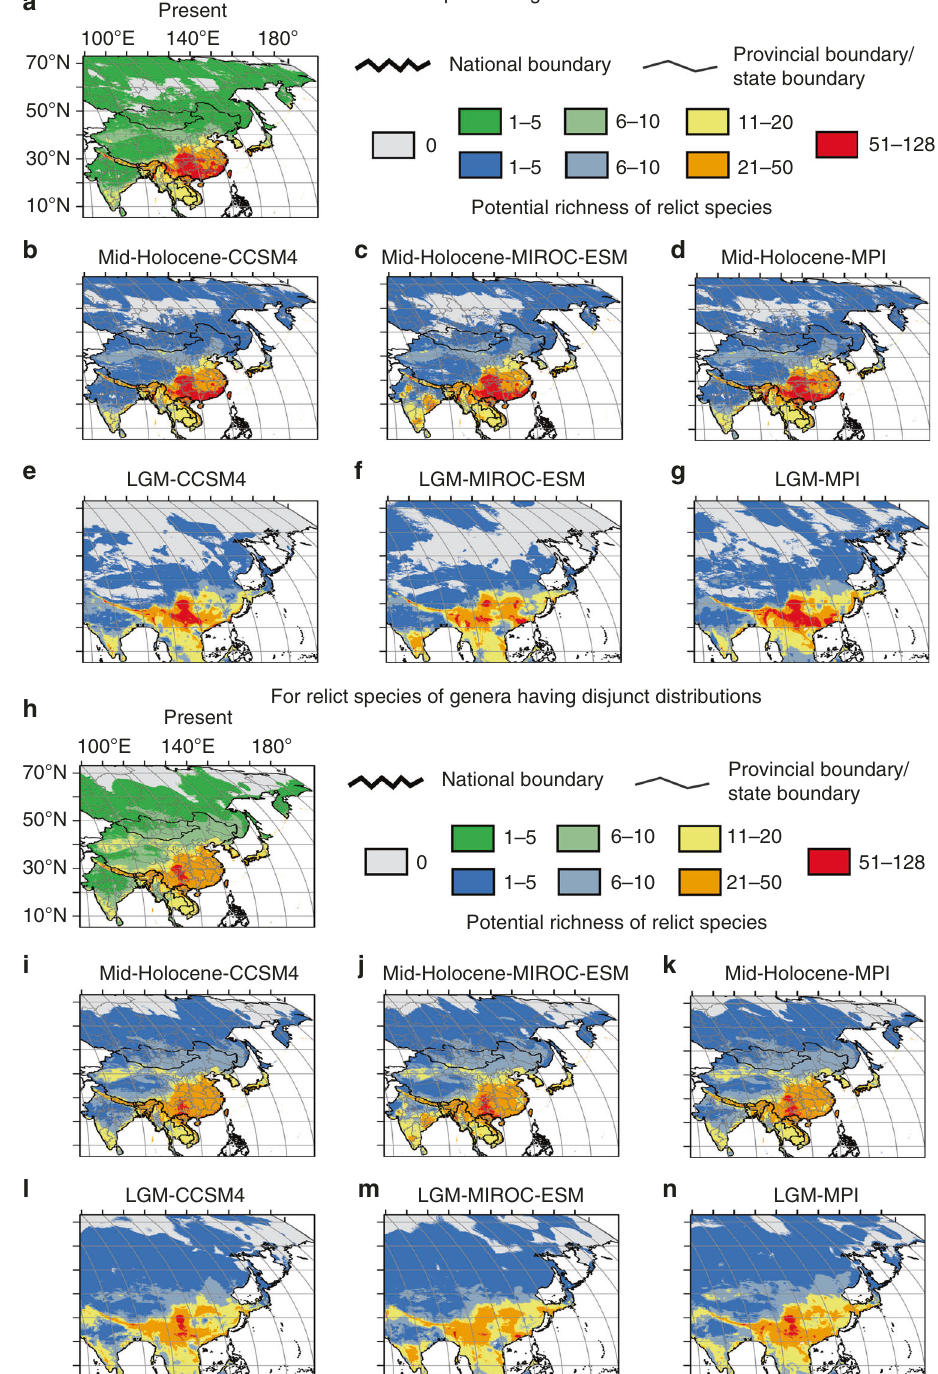
Fig. 3 A comparison of potential richness of relict species under the present climate and climatic scenarios in the past. a – g For potential richness of relict species of genera endemic to East Asia: a under the present climate; b – d under scenarios mid-Holocene-CCSM4, mid-Holocene-MIROC-ESM, mid- Holocene-MPI, respectively; e – g under scenarios LGM-CCSM4, LGM-MIROC-ESM, LGM-MPI, respectively. h – n For potential richness of relict species of genera having disjunct distributions: h under the present climate; i – k under scenarios mid-Holocene-CCSM4, mid-Holocene-MIROC-ESM, mid-Holocene- MPI, respectively; l – n under scenarios LGM-CCSM4, LGM-MIROC-ESM, LGM-MPI, respectively. For the national boundary between China and India, please see Supplementary Fig. 2A and Methods. Maps were generated using the software ArcGIS v. 10.5 (ESRI, Redlands, CA, USA) and modi fi ed using Canvas 12 (ACD Systems of America, Inc., Seattle, WA, USA). Map layers were obtained from site